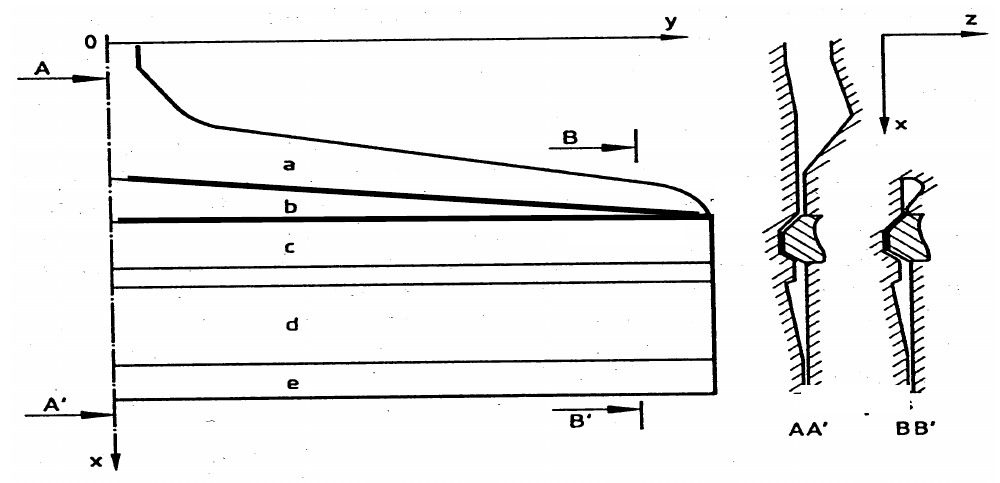
Figure 23. Coat-hanger die geometry. Only half of the geometry is represented (Reprinted from Ref. [2]).